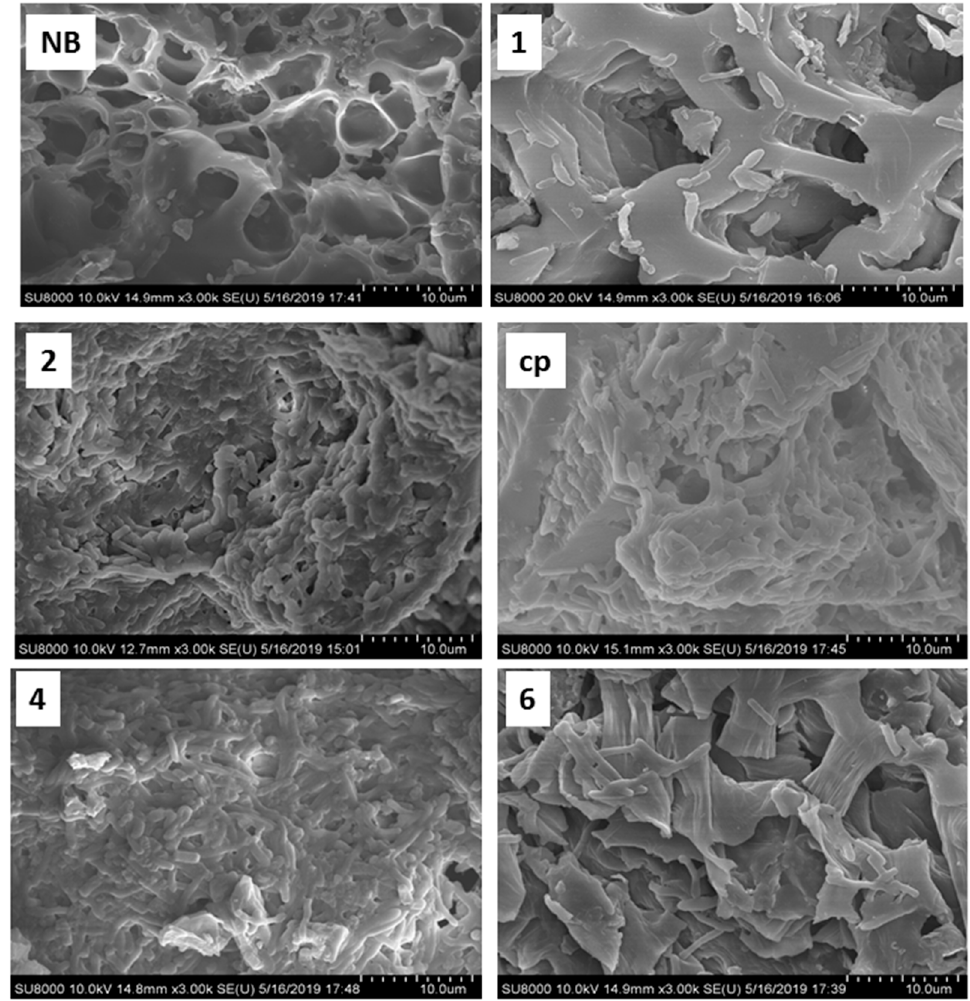
Figure 3. SEM micrographs of the bacterial biofilm formation on multifunction biochar at different pH values and arsenic concentrations. Note: NB: native biochar, 1, 2, 4, 6 and cp: correspond to the experimental conditions according to Table 1.